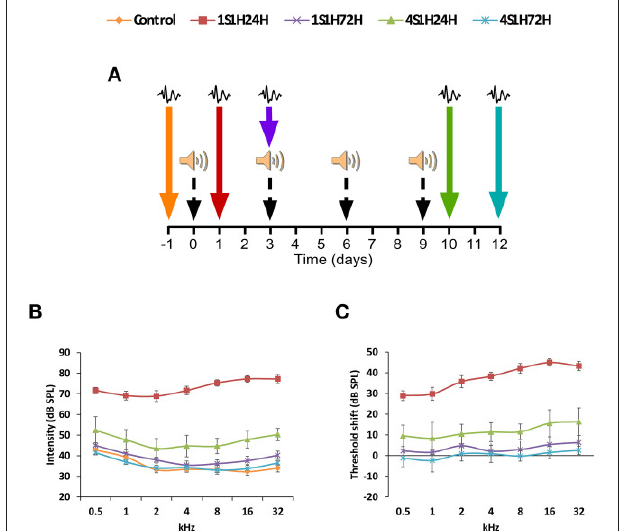
FIGURE 1 | (A) Wistar rats were exposed to a noise-induced toughening protocol consisting of 1h continuous white noise at 118dB SPL in four different sessions, with a recovery time of 72h between sessions. The ABR recordings were performed before the noise exposure and then at 24 (1S1H24H) and 72h (1S1H72H) after the first session and at 24 (4S1H24H) and 72h (4S1H72H) after the fourth session of the noise-induced toughening protocol. (B) Line graphs illustrating the relationship between the auditory thresholds and the frequencies evaluated in control and experimental groups. Note that the mean values in 1S1H24H rats were increased at all frequencies compared to control and the other experimental groups. Values in 4S1H24H animals were slightly increased mainly in the higher frequencies when compared to control and experimental rats. (C) In comparison to the control condition, the largest threshold shift was observed at 24h after the first session and ranged from 28.93 to 44.96dB. However, by 24h after the fourth session the threshold shift varied from 8.35 to 16.34dB. Color arrows indicate the time point at which the ABRs were performed and black dashed arrows show the corresponding sessions of the noise-induced toughening